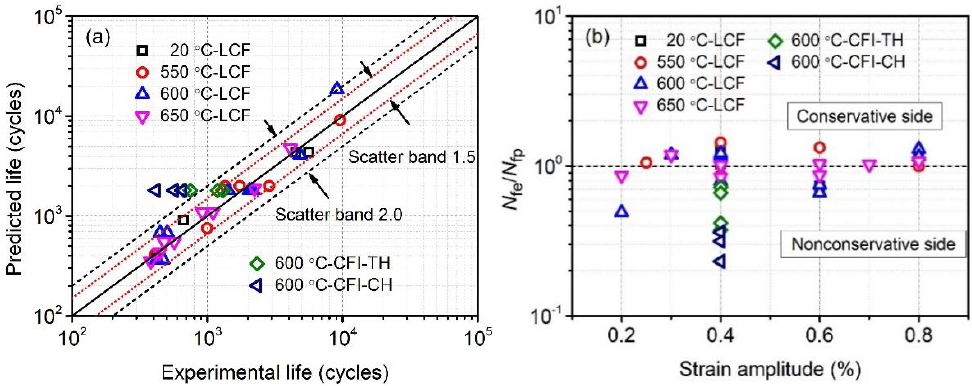
Figure 6. ( a ) Comparison between experimental life and predicted life using MCB model, ( b ) the ratio of experimental life to predicted life versus different strain amplitudes.